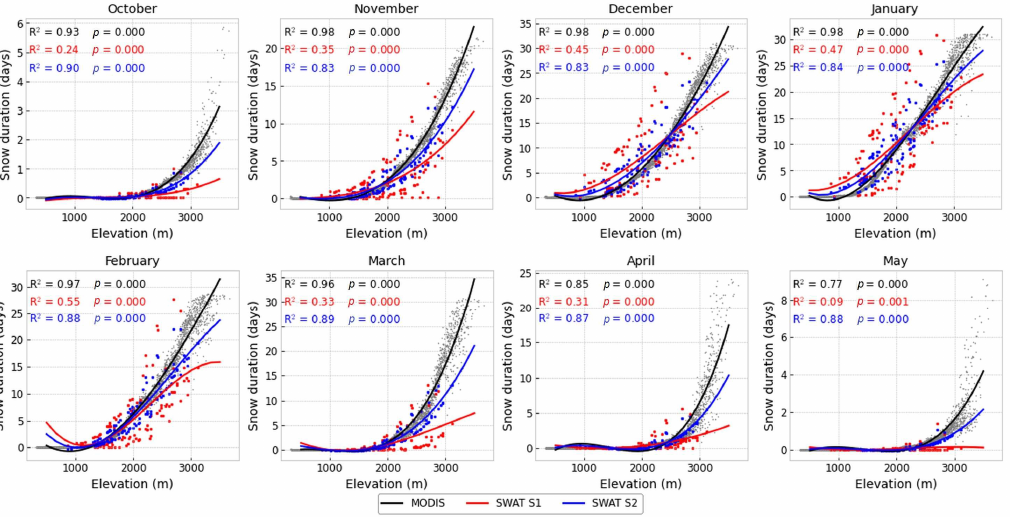
Figure 6. Relationships between altitude and snow duration from MODIS (black), SWAT S1 (red), SWAT S2 (blue).